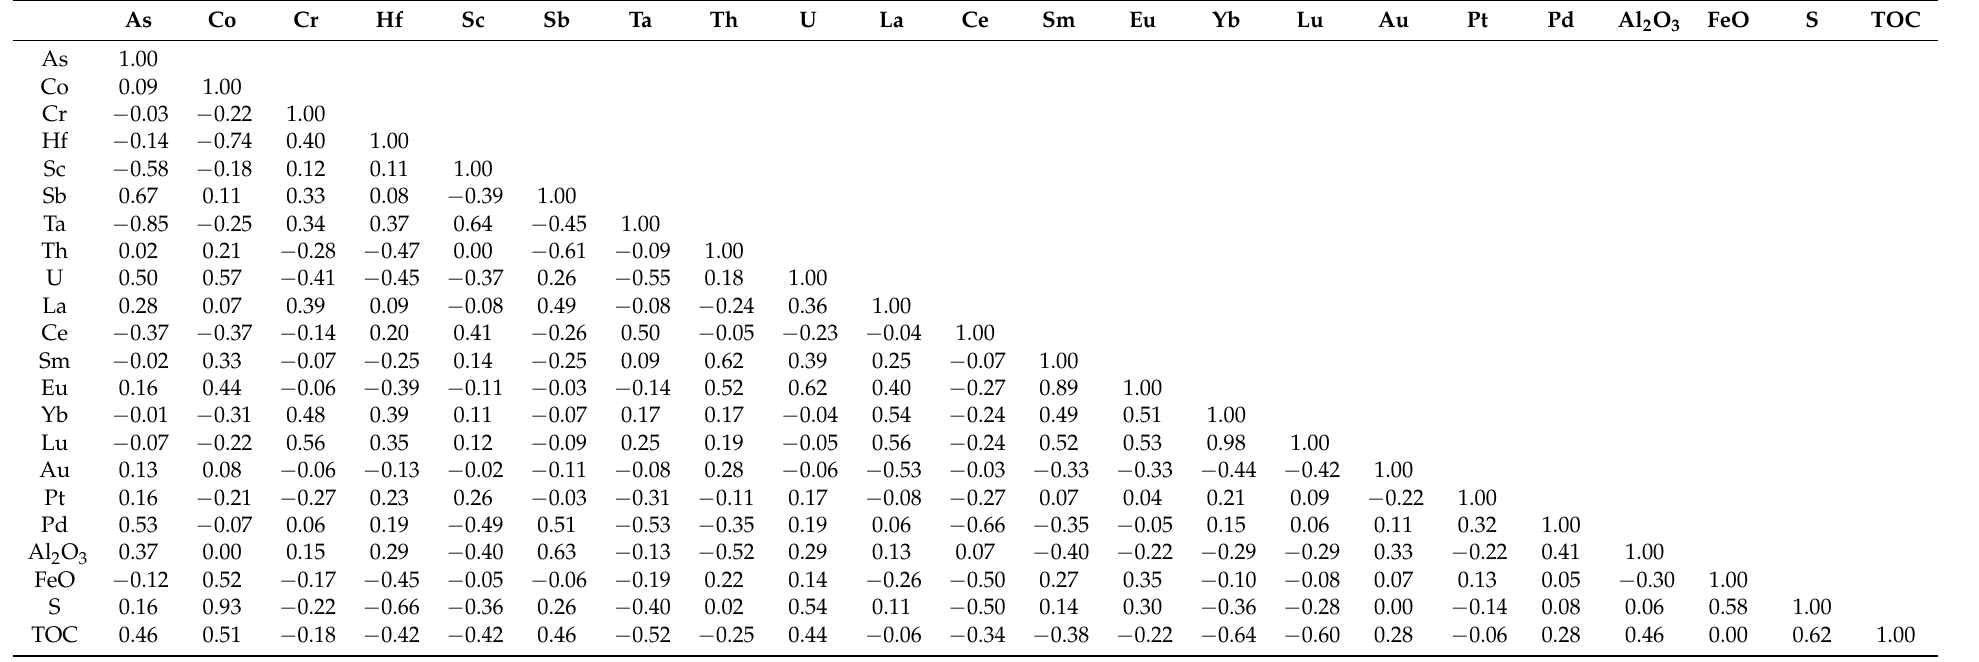
Table 2. Correlation matrix of major and trace elements in bauxites from a transitional zone of the Parnassos-Ghiona bauxite deposit. Data from Table